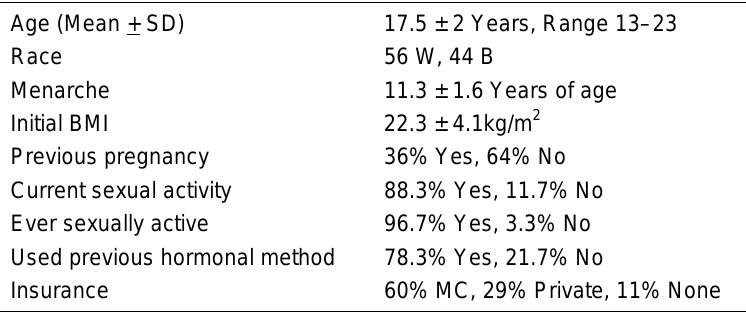
Demographic and Clinical Profiles of